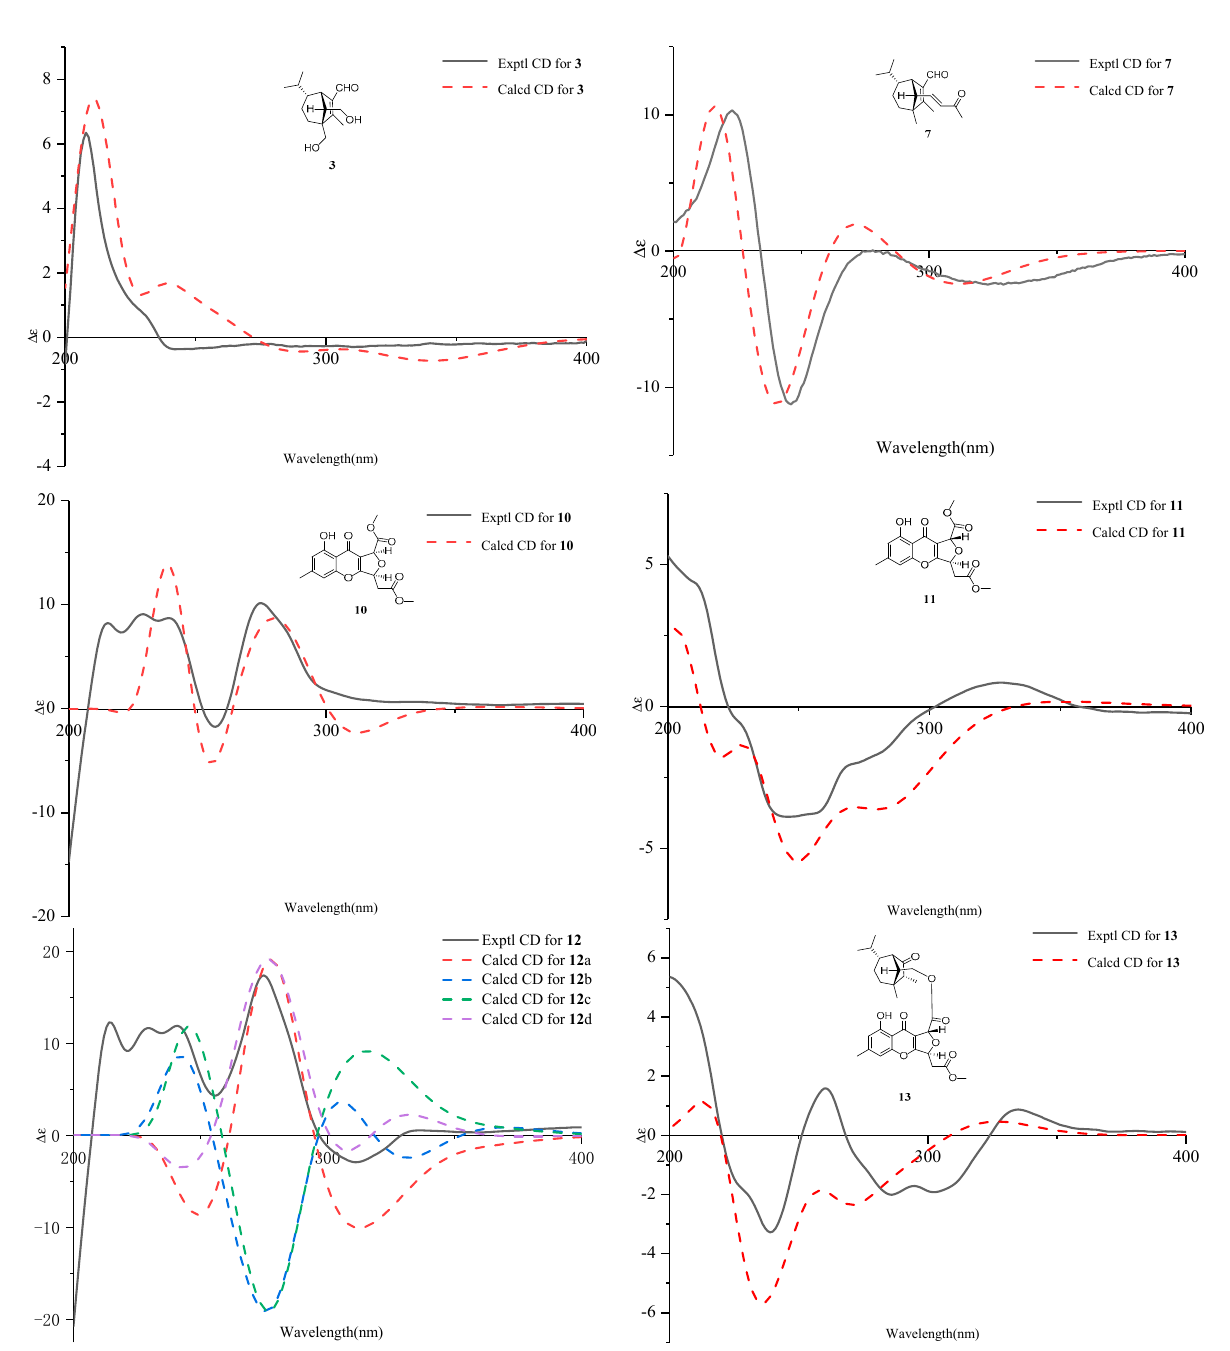
ROESY cross-peak (Figure 3) of H-2/Ha-14 (H, dd, J = 10.7, 5.0 Hz, δ H 3.85) suggested that H-2 was β oriented. Other ROESY data revealed the same patterns to 3 . Finally, regarding the same origin of 6 and 3 , the absolute configuration of 6 was identified to be the same as that of 3, as depicted.